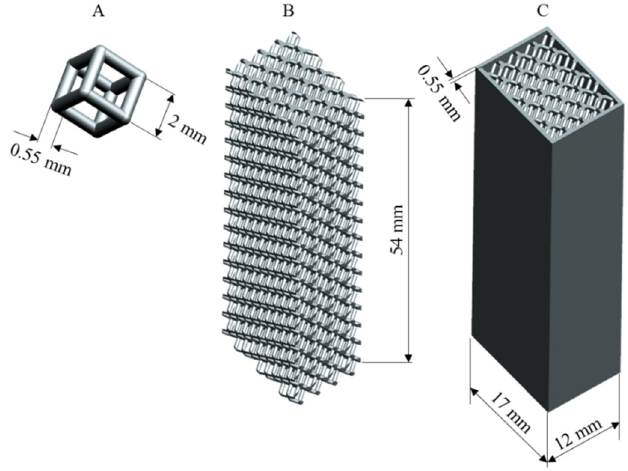
Figure 4. CAD file of the developed architecture: ( A ) rotated cube unit cell; ( B ) cell replication; ( C ) tubular lattice.